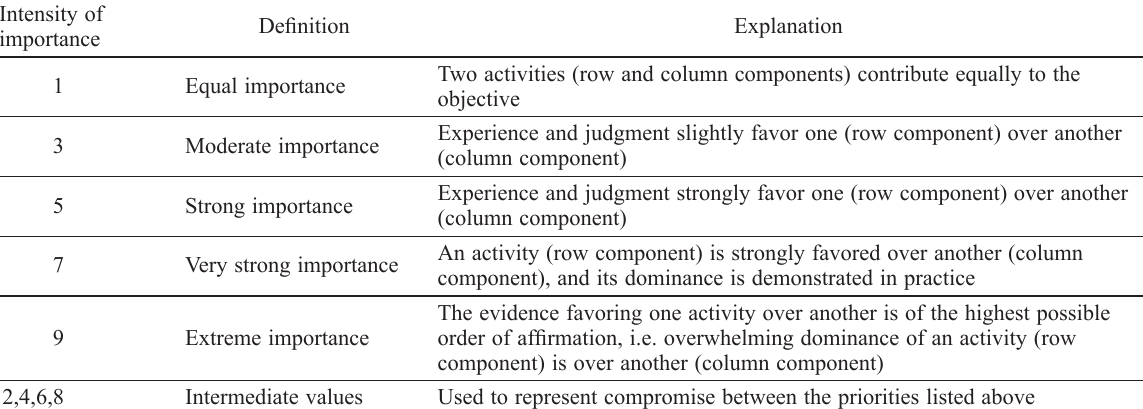
Table 2. Nine-point priority scale for ANP Intensity of